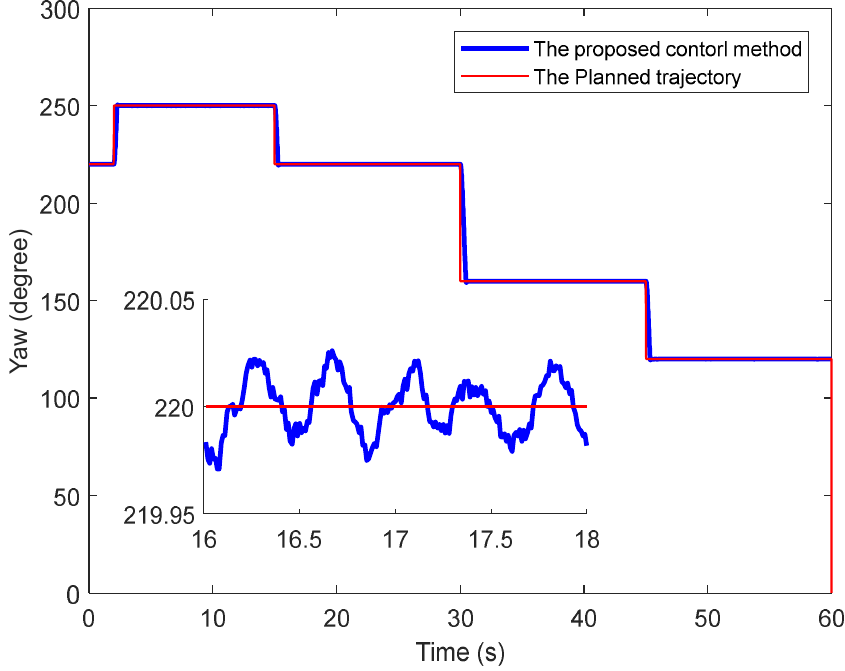
Figure 12. The flight trajectories of pitch gimbal in inspection test.